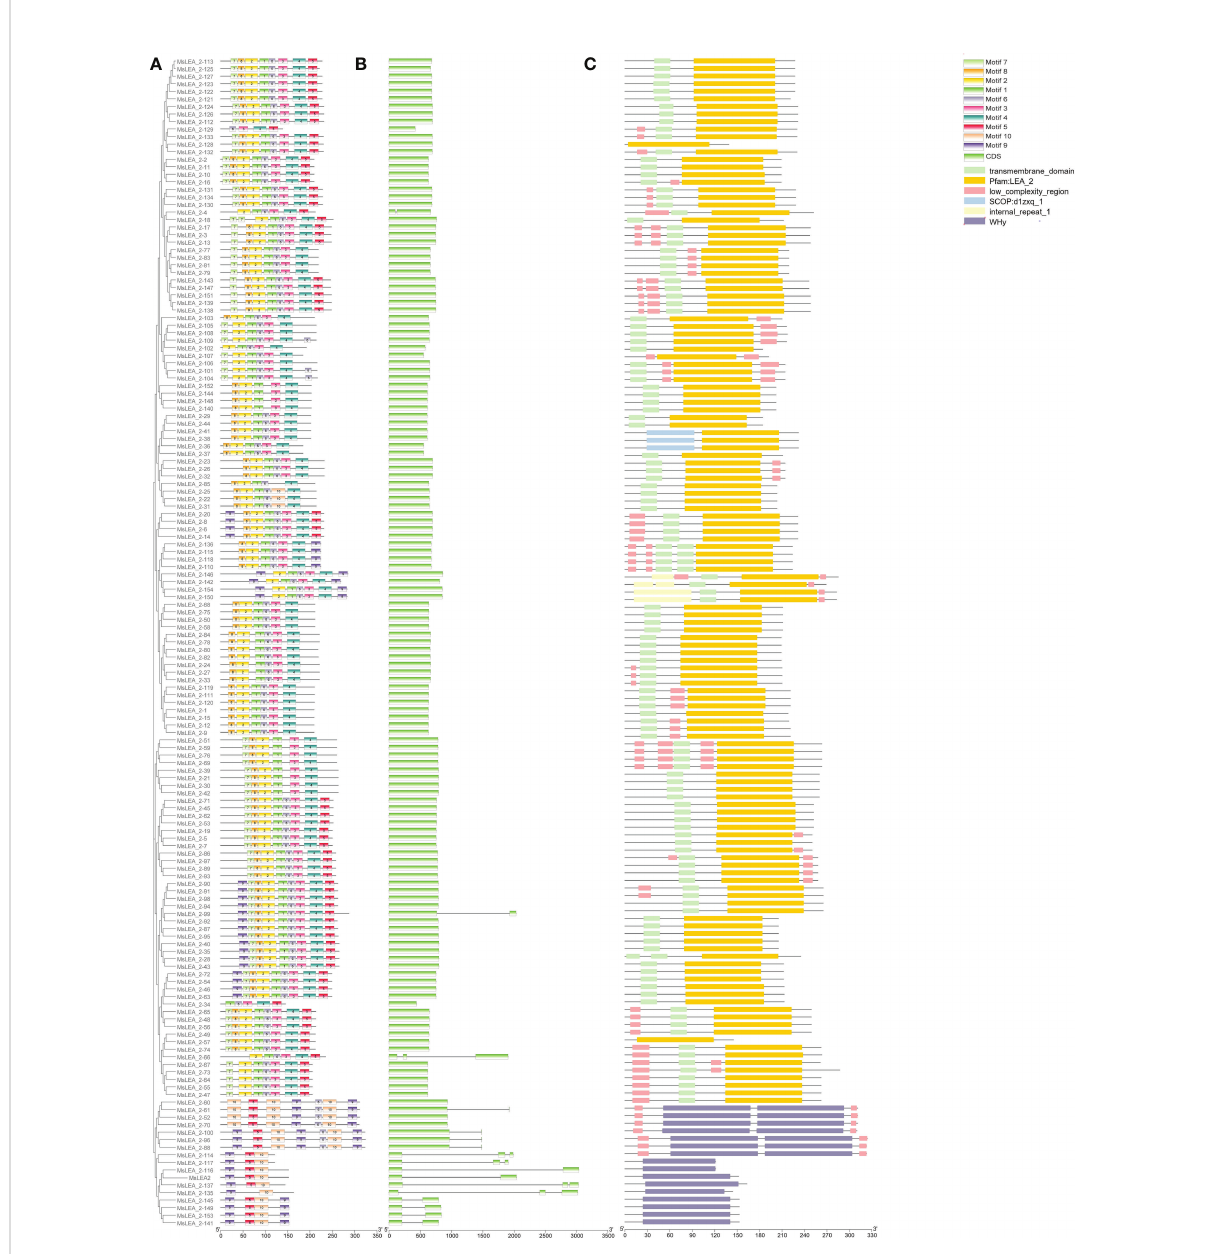
FIGURE 6 The conservative motifs, gene structure, and conservative domains of MsLEA _2 gene family. (A) The phylogenetic tree constructed by Clustal X tool was shown on the left. Conserved motifs of MsLEA _2 proteins were shown on the right, and these motifs were identi fi ed by MEME and boxes with different colors represent different motifs. (B) The structure of exons and introns of the MaLEA genes were inferred and visualized by TBtools. The genes are arranged according to phylogenetic order. The exons of the genes are colored to be easily distinguishable. (C) The conservative domains of MsLEA _2 were predicted by the Pfam database (http://pfam.xfam.org/). The difference conserved domains were marked by difference color boxes, shown on the